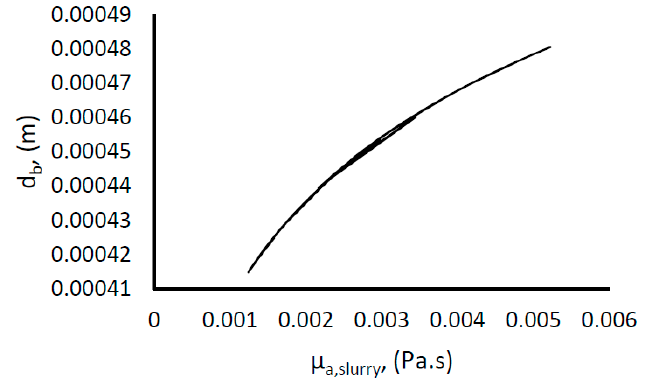
Figure 8. Estimated mean bubble diameter during hydrate growth.